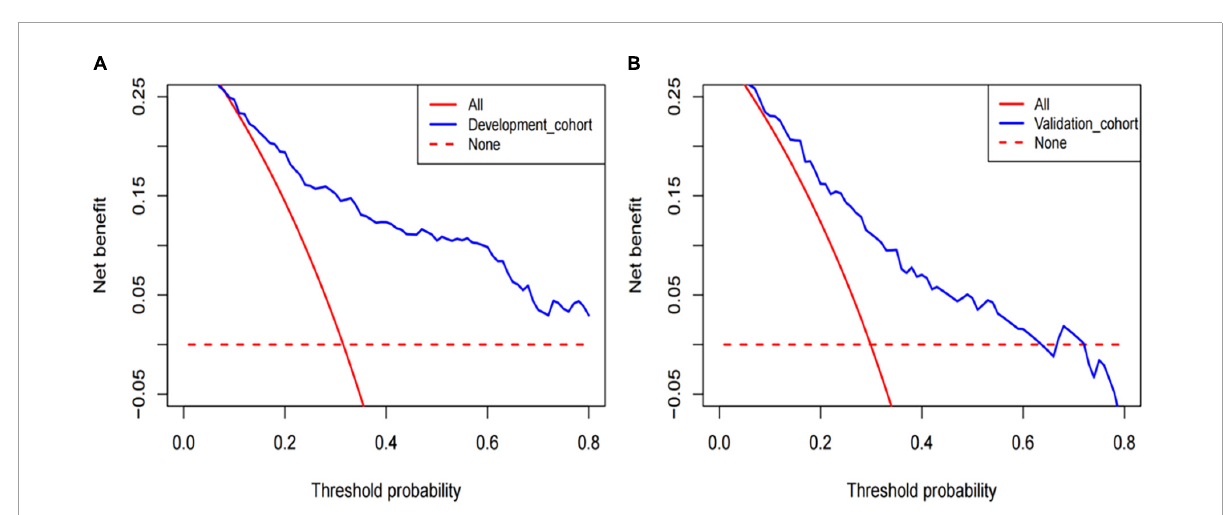
FIGURE5 The decision curve analysis (DCA) was performed in development cohorts (A) and validation cohorts (B)